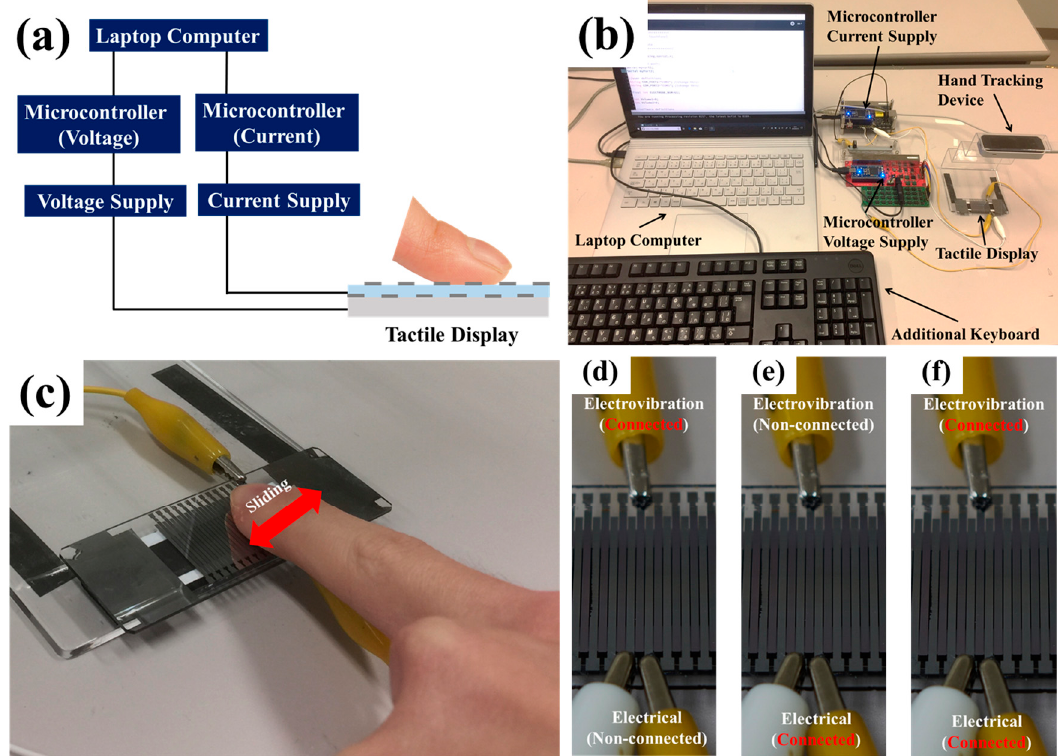
Figure 6. ( a ) Schematic illustration of the experimental setup. ( b ) Actual photograph of the experimental setup. ( c ) Actual photograph of the experiment. ( d ) Electrode connection for the electrical stimulus evaluation. ( e ) Electrode connection for the electrovibration stimulus evaluation. ( f ) Electrode connection for the multiple stimuli evaluation.